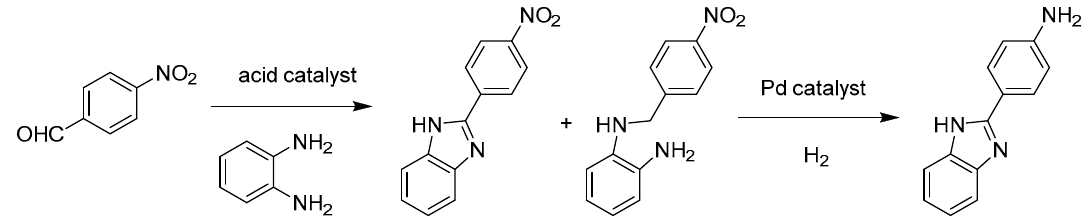
Figure 2. Synthesis of 2-(4-aminophenyl)-1 H -benzimidazole via tandem catalysis involving acid catalysis and catalytic hydrogenation of nitro groups using Pd@MIL-101(Cr) as bifunctional catalyst.